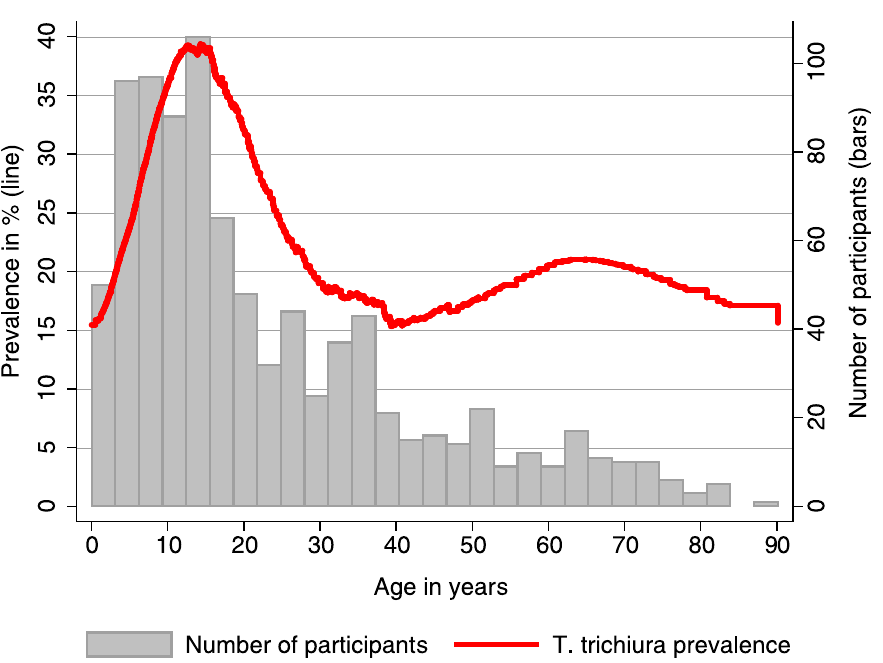
Fig 3. T . trichiura prevalence by age. The red line shows LOWESS-smoothed T . trichiura infection prevalence, grey bars indicate the numberof participantsin each age stratum.